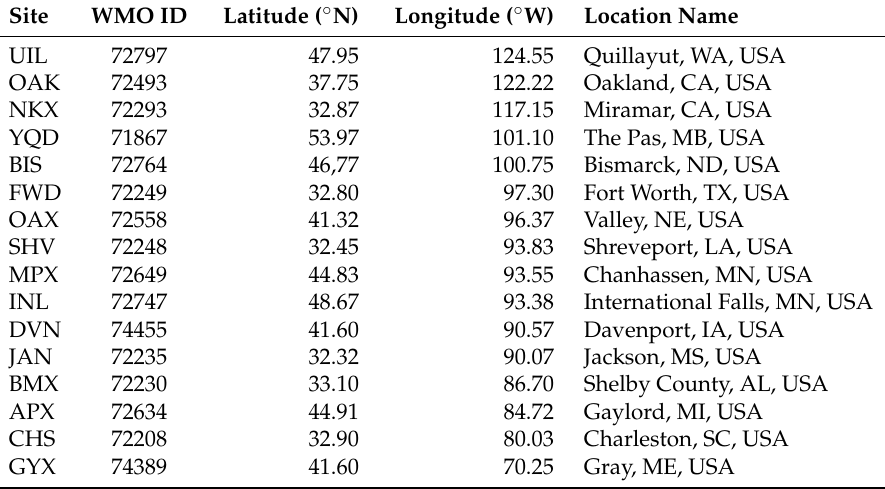
Figure 15. Seasonal mean wind direction bias [degrees] at selected rawinsonde sites for 00 UTC soundings in 2010 for WRF initialized with ERA-Interim reanalysis and for GEOS-5 reanalysis at 925 hPa for: ( a ) spring, ( b ) summer, ( c ) fall, and ( d ) winter. Table 5. Rawinsonde sites used in comparison of 00 UTC modeled horizontal